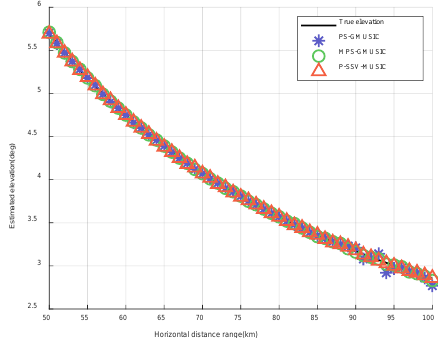
Figure 9. Elevation measurement results of target.